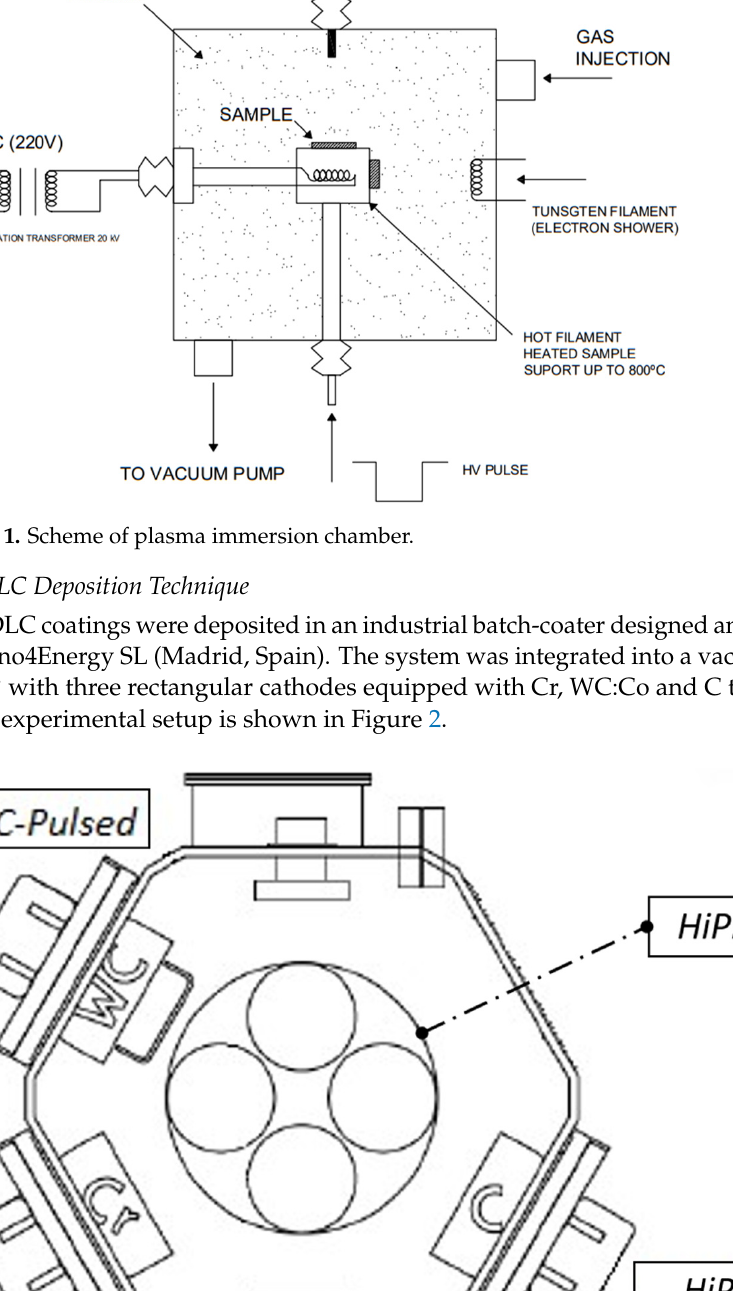
Figure 2. Scheme of the HiPIMS chamber in a horizontal cross-section.